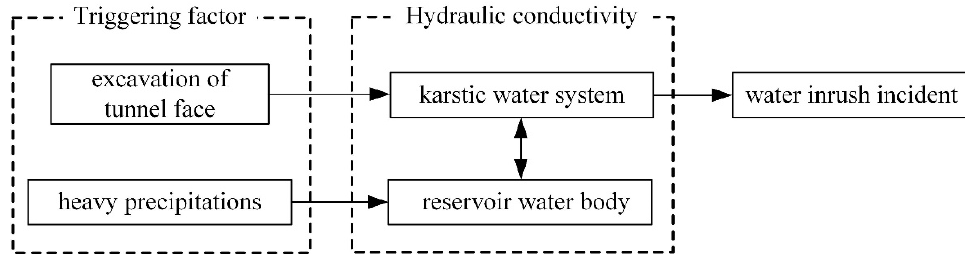
Figure 8. Schematic flowchart of water inrush incident.